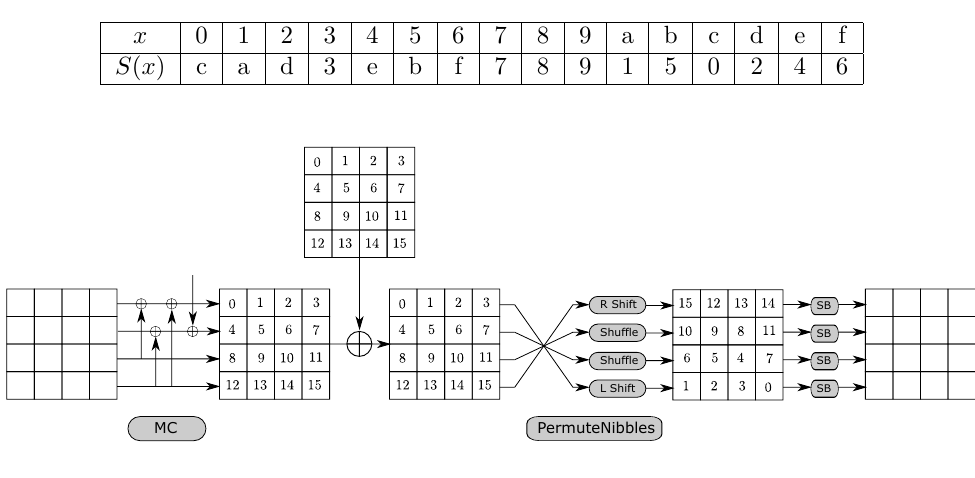
Figure 13: A round function of